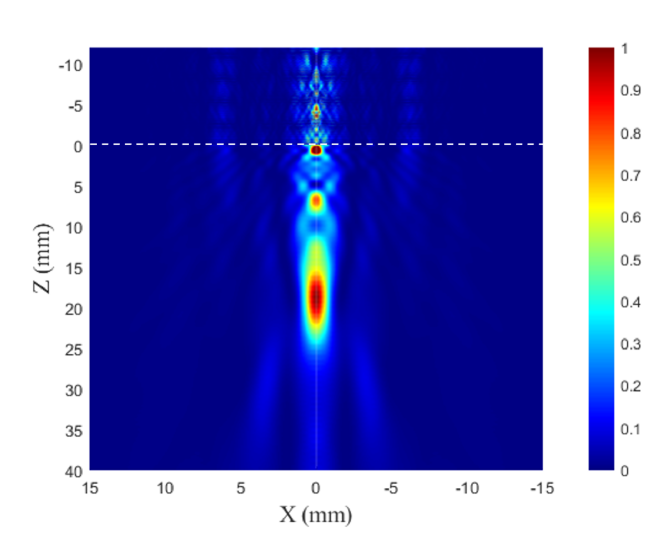
Figure 3. Numerical results for normalized acoustic intensity.